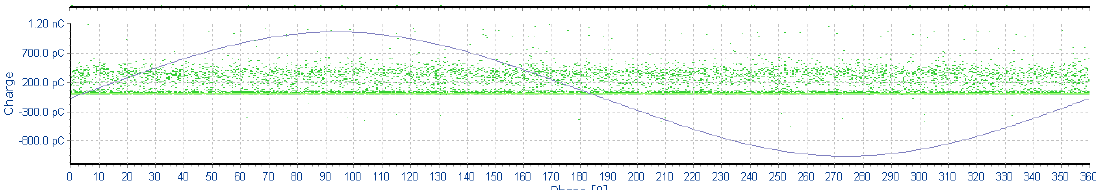
Figure 7. Pattern diagram for partial discharges under 6.6kV DC conditions. (the blue line is the internal voltage reference of PD smart meter and not the applied voltage, which is DC in